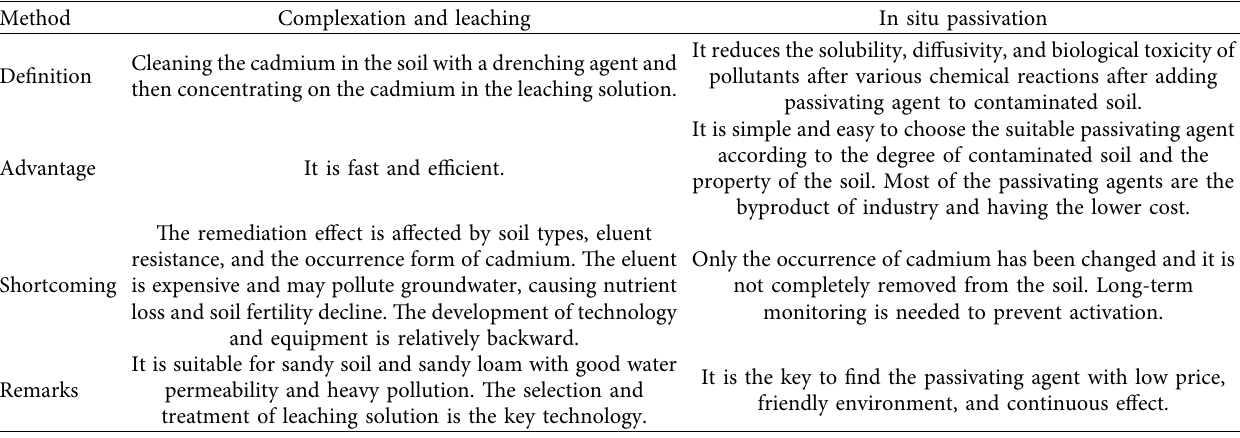
Table 1: Chemical remediation of cadmium pollution in